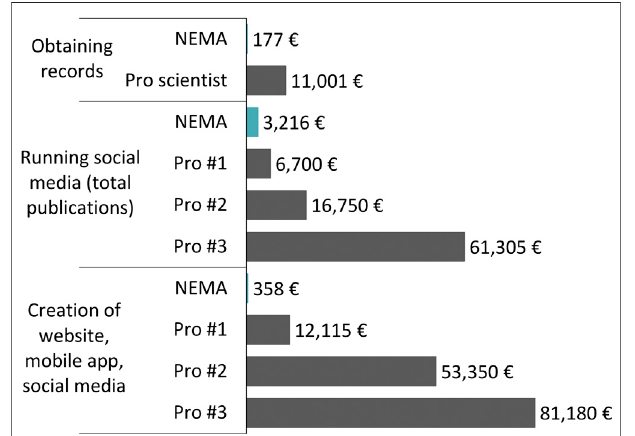
FIGURE 7 | Cost comparison between investing our time in running the citizen science campaign ourselves (NEMA); the minimum cost for a professional scientist to retrieve the same 166 observations submitted by citizen scientists; and three quotations provided for a social media manager to handle the same 335 publications made by NEMA ’ s Facebook account, and for a professional to create all of NEMA ’ s communication channels.